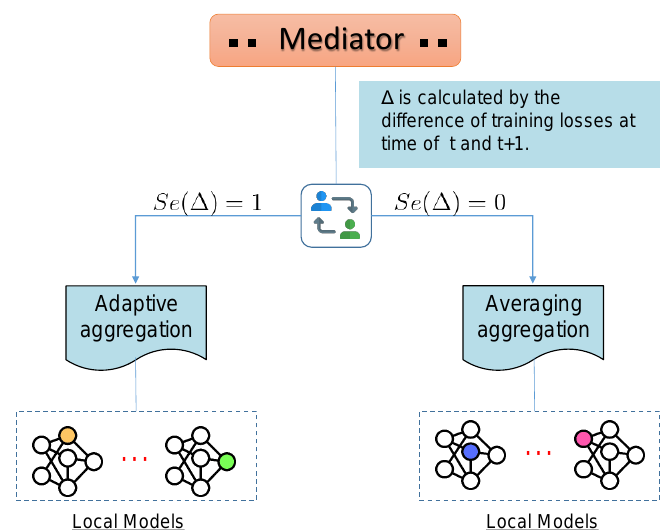
Figure 2. The illustration of how the mediation incentive scheme works.